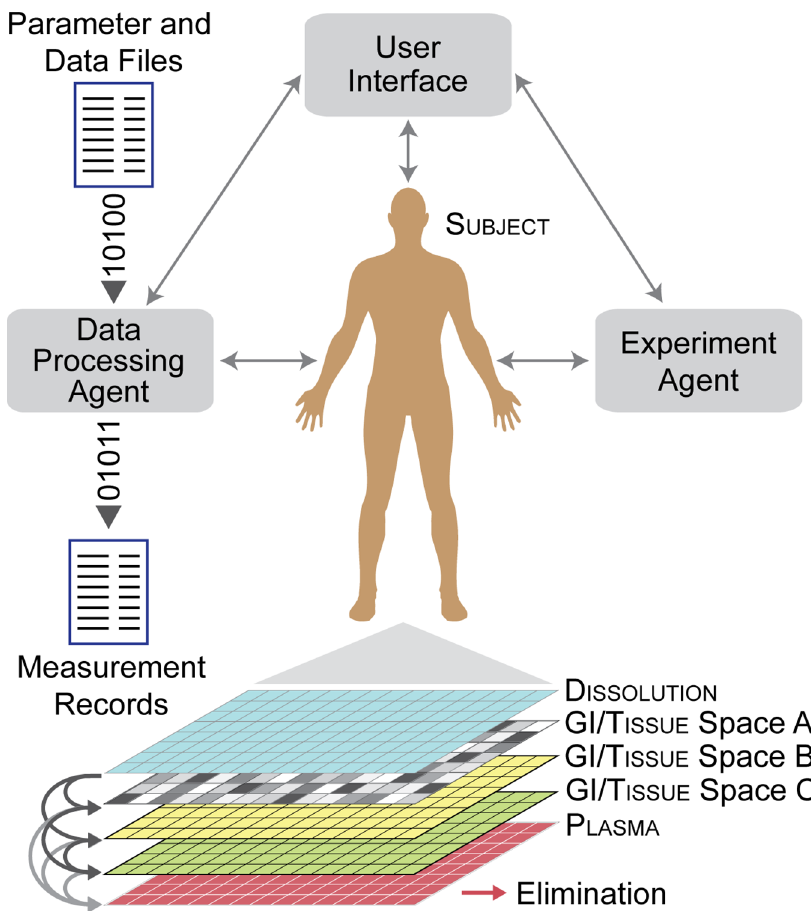
Figure 1. Simulation platform. The computational framework is a coarse grain analog of whole-body drug disposition experiments. It has features to manage, support, and semi-automate simulation and analysis. An object-oriented, agent-based, discrete event model is integrated within the framework; it is an executable software analog of a subject undergoing study. We used two-dimensional, square grids to represent basic physiological features such as plasma and GI tract, which are interconnected to simulate drug movement across individual sites and elimination from the system.